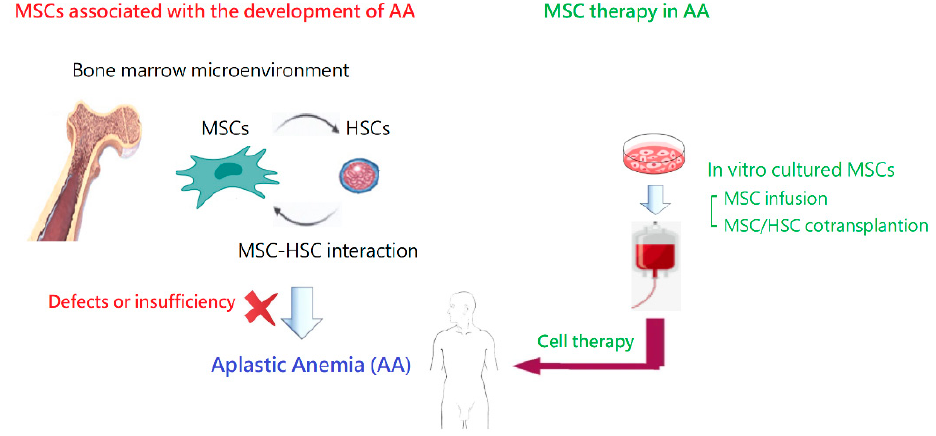
Figure 4. Association between MSCs and the development of AA and MSC therapy in AA.